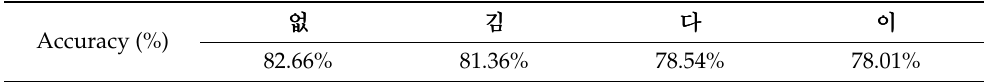
Table 1. Verification accuracy of single character.